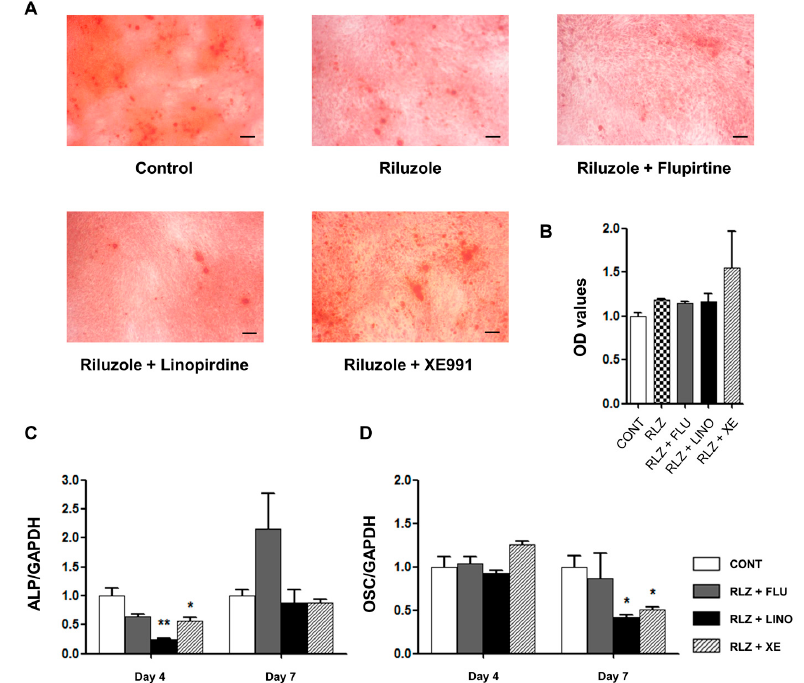
Figure 13. Counter-effect of riluzole, a glutamate release inhibitor, on osteoblastic differentiation promoted by K V 7.3 blockers. ( A ) Alizarin Red S staining showed that riluzole (30 μ M) co-applied with flupirtine (30 μ M), linopirdine (30 μ M), or XE991 (10 μ M) produced mineralization levels similar to those of the controls ( n = 3); ( B ) The OD values are shown parallel to Alizarin Red S staining results. The relative mRNA expression levels of osteoblastic differentiation markers, including ALP and OSC, were measured with qRT-PCR and normalized against GAPDH (glyceraldehyde 3-phosphate dehydrogenase) expression ( n = 3); ( C ) At day 4, riluzole treatment with linopirdine or XE991 reduced the mRNA expression of ALP. At day 7, there was no significant change in ALP levels, although riluzole treatment with flupirtine had a tendency to increase these levels; ( D ) At day 7, riluzole treatment with linopirdine or XE991 reduced the OSC mRNA expression. Data are presented as mean ± SEM. * p < 0.05 and ** p < 0.01. Scale bar represents 100 μ m. CONT: non-treated controls; RLZ: riluzole; FLU: flupirtine; LINO: linopirdine; XE: XE991; ALP: alkaline phosphatase; OSC: osteocalcin; OD: optical density.